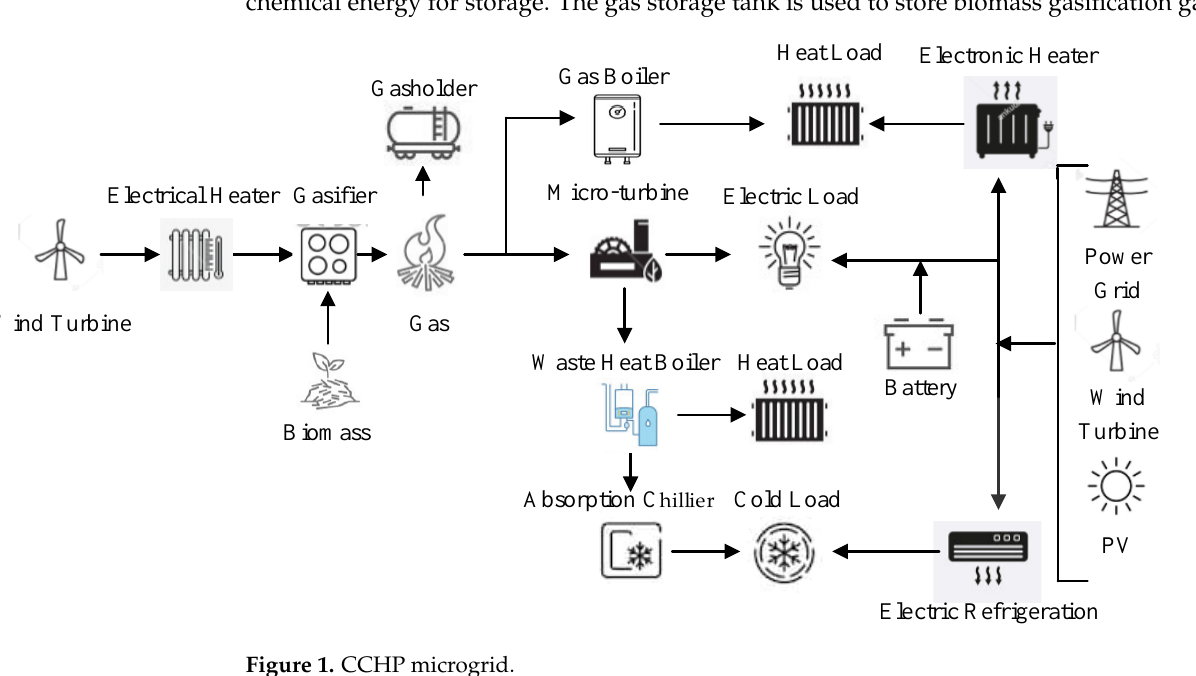
Figure 1. CCHP microgrid.